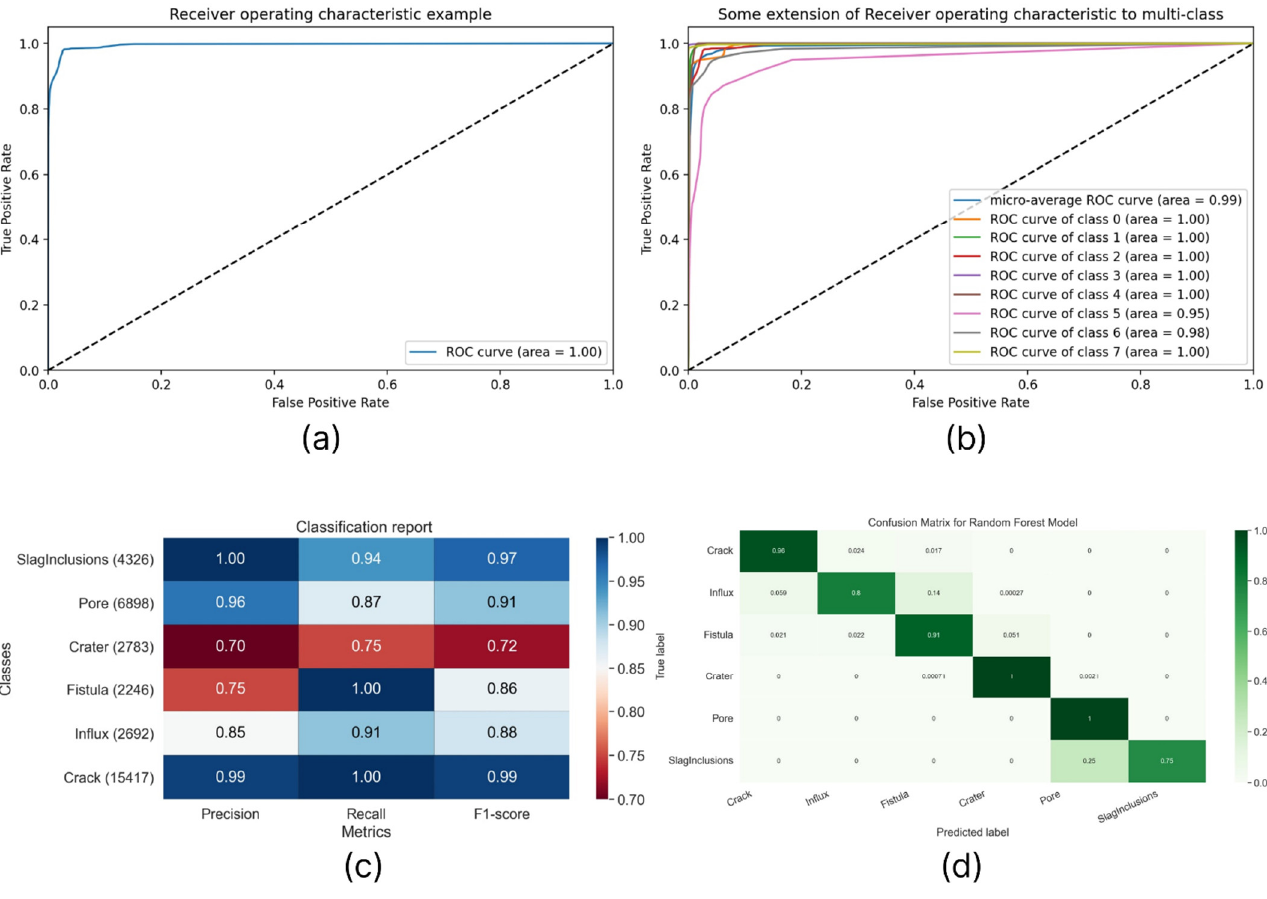
Figure 12. ( a ) Average ROC ( b ) ROC area to multilabel classification, ( c ) PRA map showing dependencies average precision, recall, and F1-score metrics. ( d ) Confusion matrix.